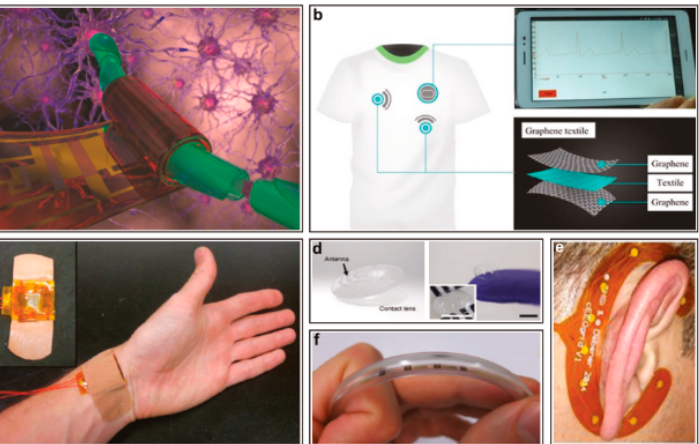
Figure 5. Applications for bio-monitoring, diagnosis, and hazards prevention [9]. ( a ) Flexible electronics for regenerative neuronal cuff implants [62]. ( b ) Flexible graphene wearable electrodes for dynamic ECG sensing [63]. ( c ) Flexible polymer transistors for application in electronic skin and health monitoring [64]. ( d ) Contact lens with ocular diagnostics of detecting the glucose levels in tears in diabetes patients [65]. ( e ) Ambulatory and wearable EEG sensor around the ear [66]. ( f ) Electronic nose on a flexible substrate for detecting hazardous gases [67].